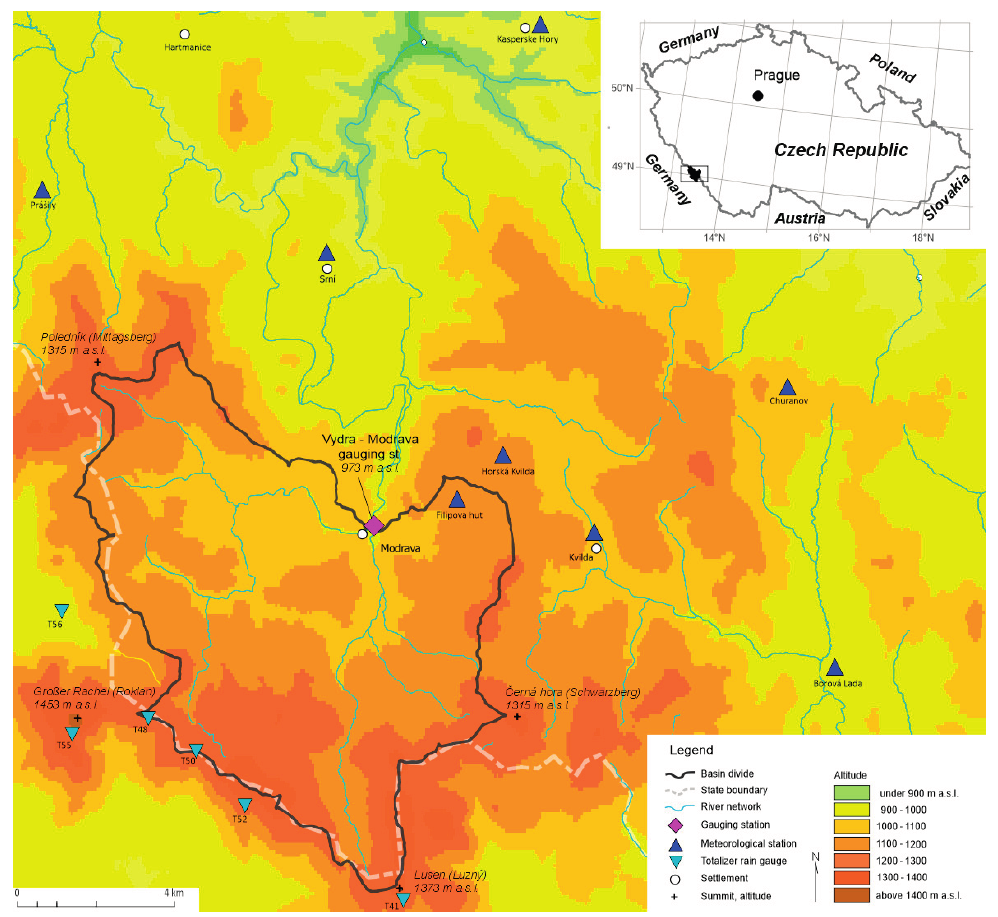
Figure 1. Study area. Location of the upper Vydra basin with river network, gauging and meteorological